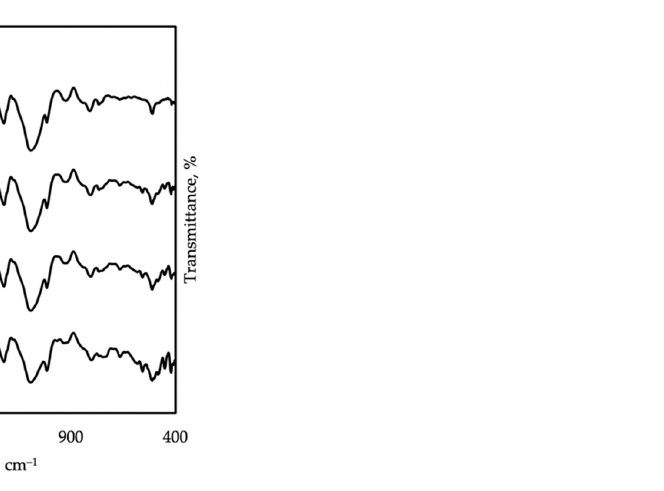
Figure 3. FTIR spectra taken on reference samples, 5% Al-FR, 10% Al-FR, and 15% Al-FR, showing the influence of aluminum hydroxide.